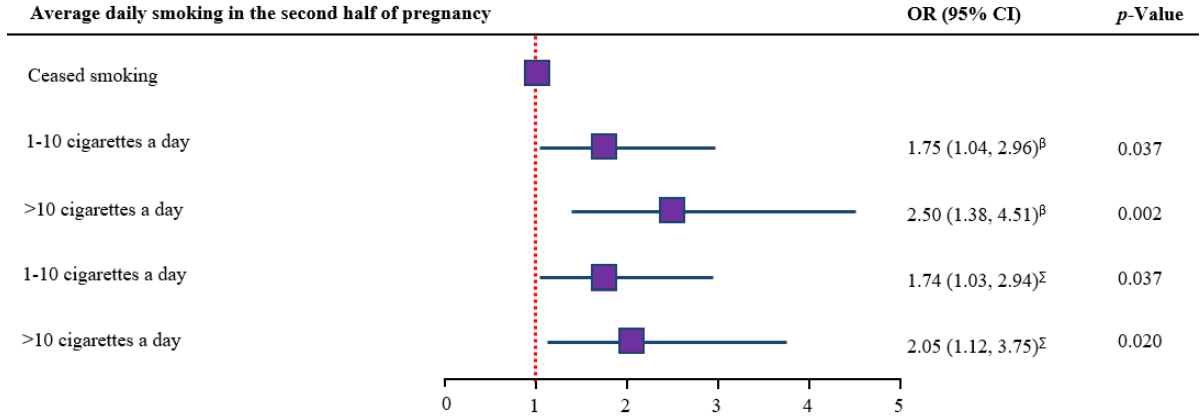
Figure 4. Smoking dose and low birth weight among pregnant smokers in SNSWLHD (2011–2019). β unadjusted odds ratio; ∑ adjusted odds ratio. Model adjusted for year of birth, socio-demographic (maternal SES category, maternal Aboriginal status, hospital of birth), maternal/fetal (maternal age at birth, history of previous pregnancy, chronic hypertension, sex of baby, type of delivery), gestational (gestational diabetes, gestational hypertension), and health promotion (number of ANC visits, duration of pregnancy at first ANC visit) variables; CI = confidence interval.